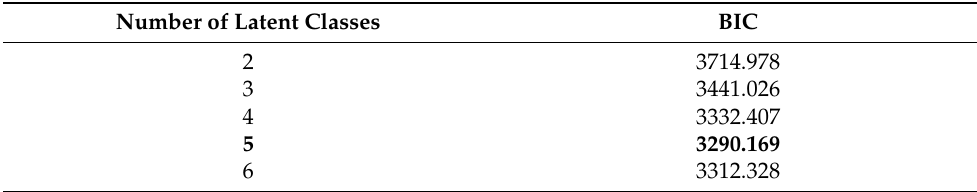
Table 2. Changing values of Bayesian Information Criterion (BIC) by varying number of classes.